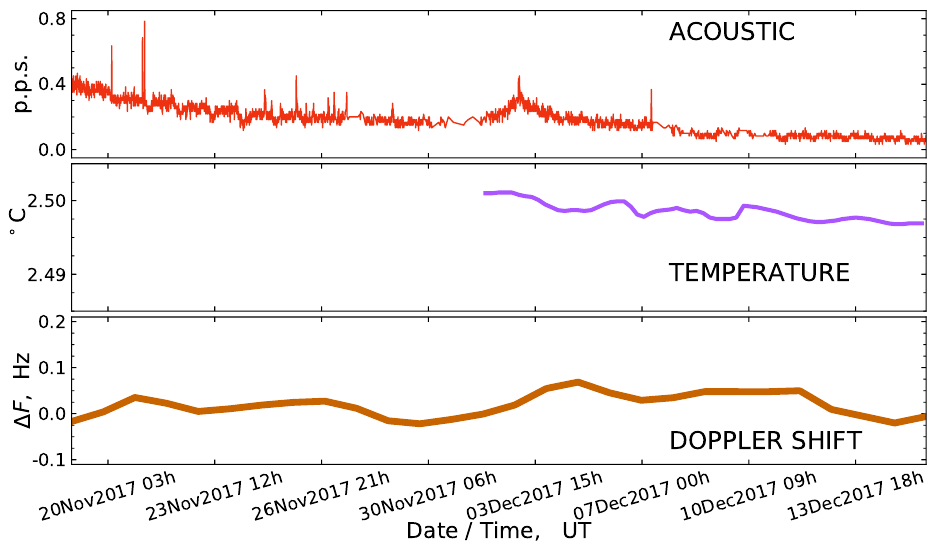
Figure 9. Time series of the intensity of acoustic pulses and temperature in the borehole, and of the Doppler shift values of ionospheric signal during November—December